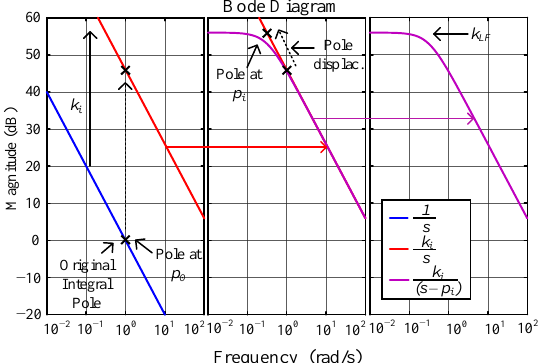
Figure 5. Steps to build the IBTF from a pure integral function (blue—no gains | red—with gains | pink—with gains and added/displaced poles).